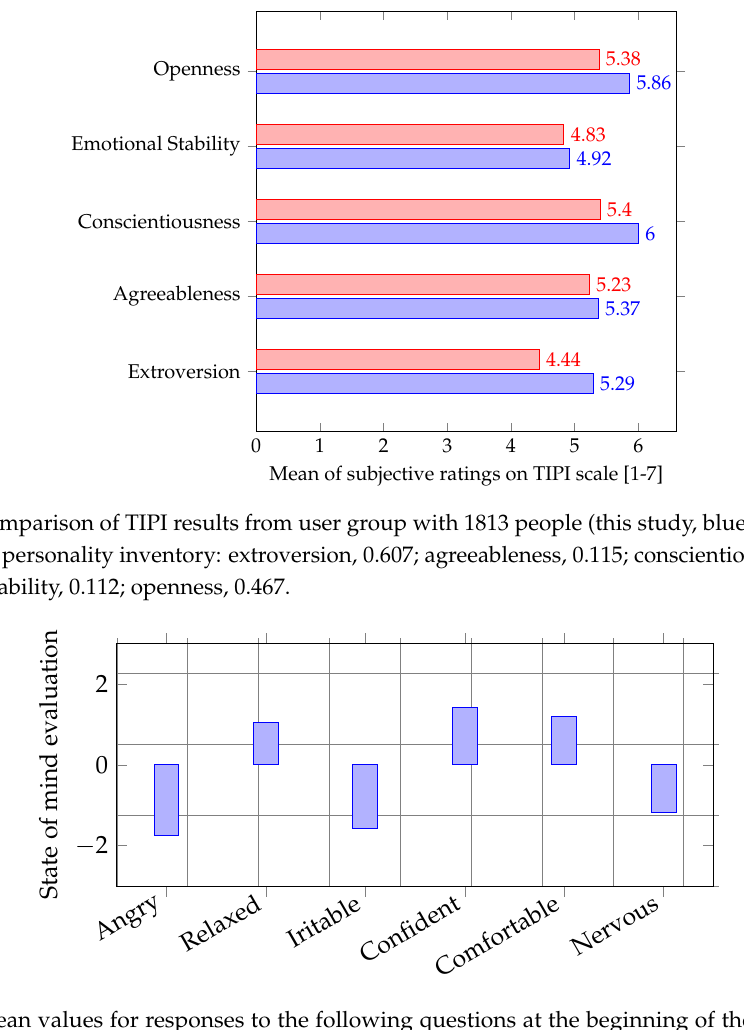
Figure 8. Mean values for responses to the following questions at the beginning of the experiment (from twenty-one participants): (1) Do you feel angry? (2) Do you feel relaxed with what we are going to do? (3) Do you feel irritable? (4) Do you feel confident? (5) Do you feel comfortable? (6) Today, did you get nervous about something that happened suddenly? ( − 2 for strongly disagree, − 1 for disagree, 0 for neutral, 1 for agree, and 2 for strongly agree) (see Appendix